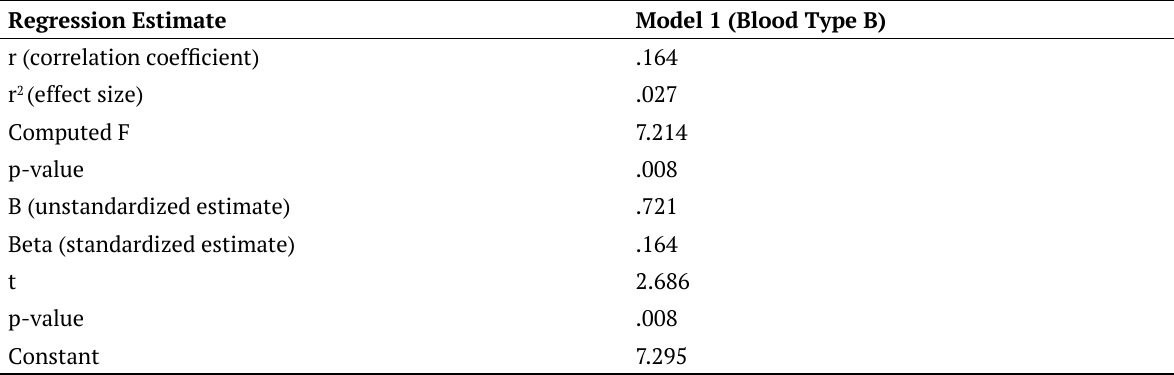
Table 10. Regression estimation procedures of the factors towards students’ speed Regression